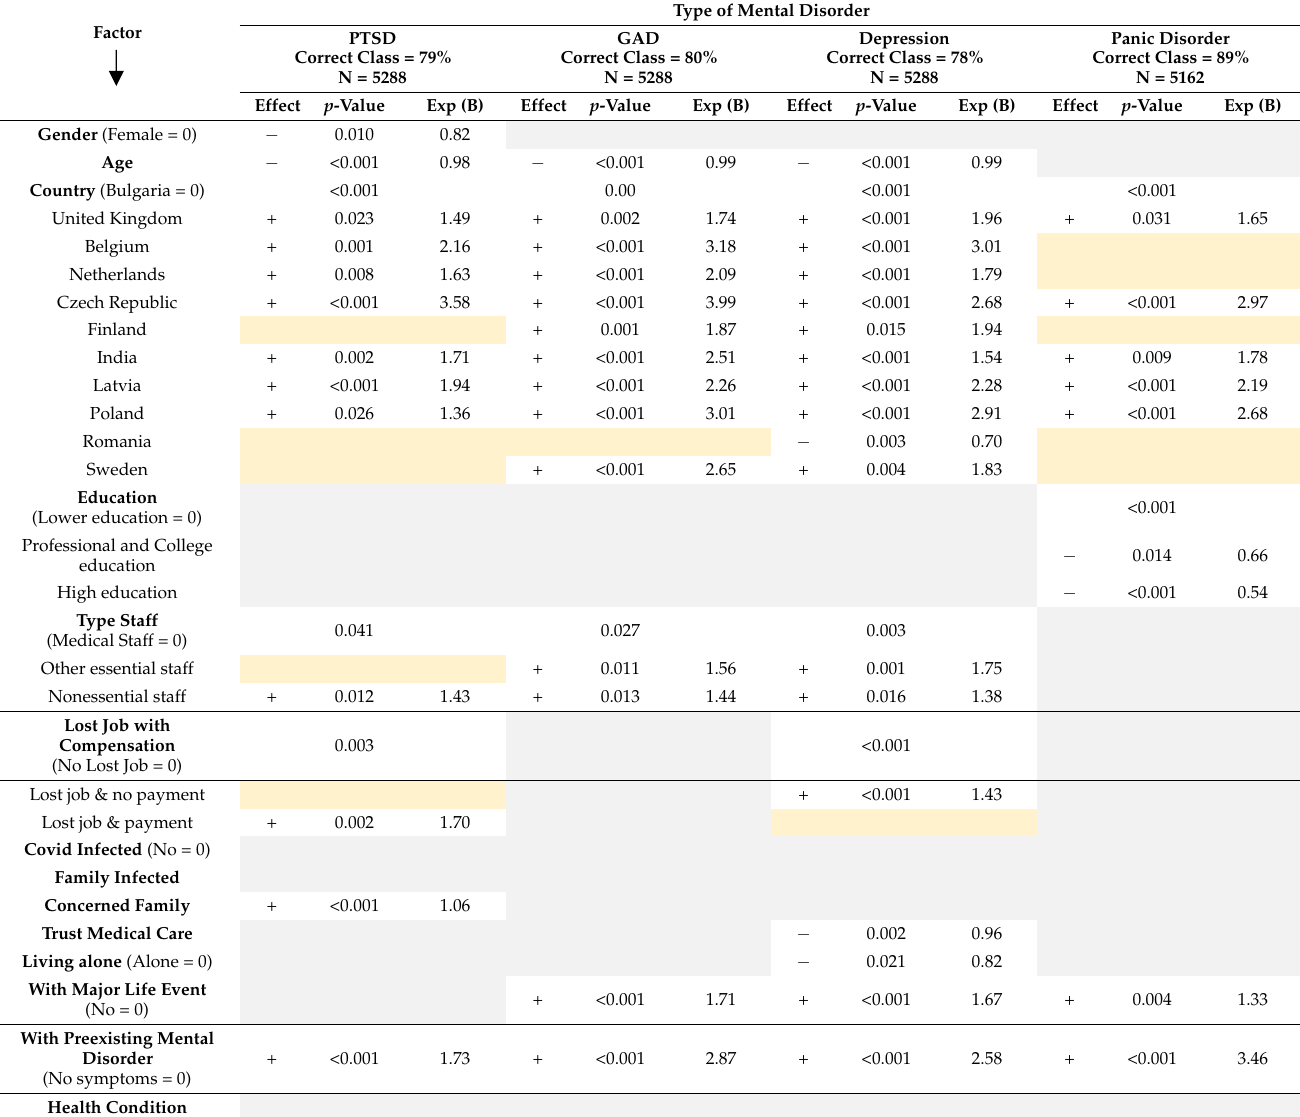
Table 1. Output from the multiple linear regressions with “Positive PTSD”, “Positive anxiety”, “Positive depression”, or “Positive panic disorder” as dependent variable and 25 independent factors.